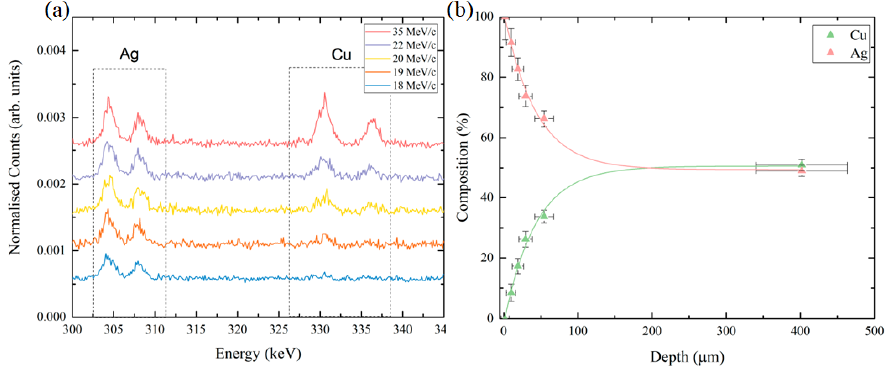
Figure 7. ( a ) Momentum scan of the sample. At low momentum, copper is absent; ( b ) composition of the alloy. The data obtained from the analysis are in agreement with the literature [35]. The data was taken and adapted from Ref. [34].